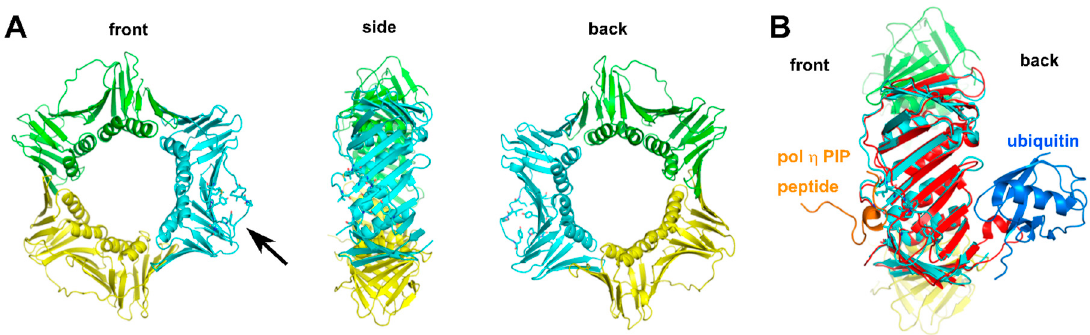
Figure 3. Structures of human PCNA and yeast ubiquitinated PCNA. ( A ) Front, side, and back views of human PCNA (PDB:2ZVK). Three subunits are shown in green, yellow, and cyan. In one subunit (cyan), amino acid residues surrounding the hydrophobic pocket near the interdomain-connecting loop are shown in stick. The black arrow is pointing at the hydrophobic pocket. For simplicity, the pol η PIP peptide is omitted from the original crystal structure. ( B ) A subunit of yeast ubiquitinated PCNA (red; PDB:3L10) is superimposed with a subunit (cyan) of human PCNA (PDB:2ZVK). The pol η PIP peptide (orange) interacts with the hydrophobic pocket on the front side of PCNA, and ubiquitin (blue) interacts with the back side of PCNA.